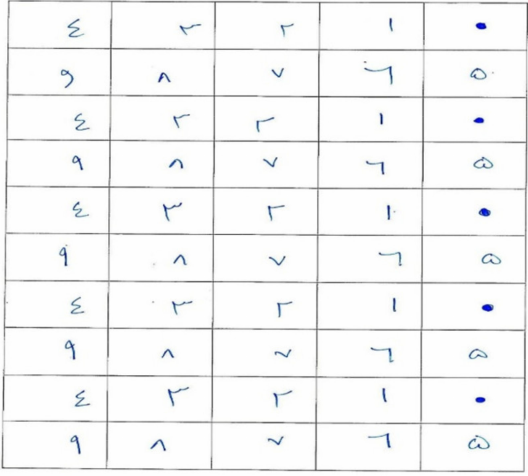
Figure 3. A sample from the Pashto Digit